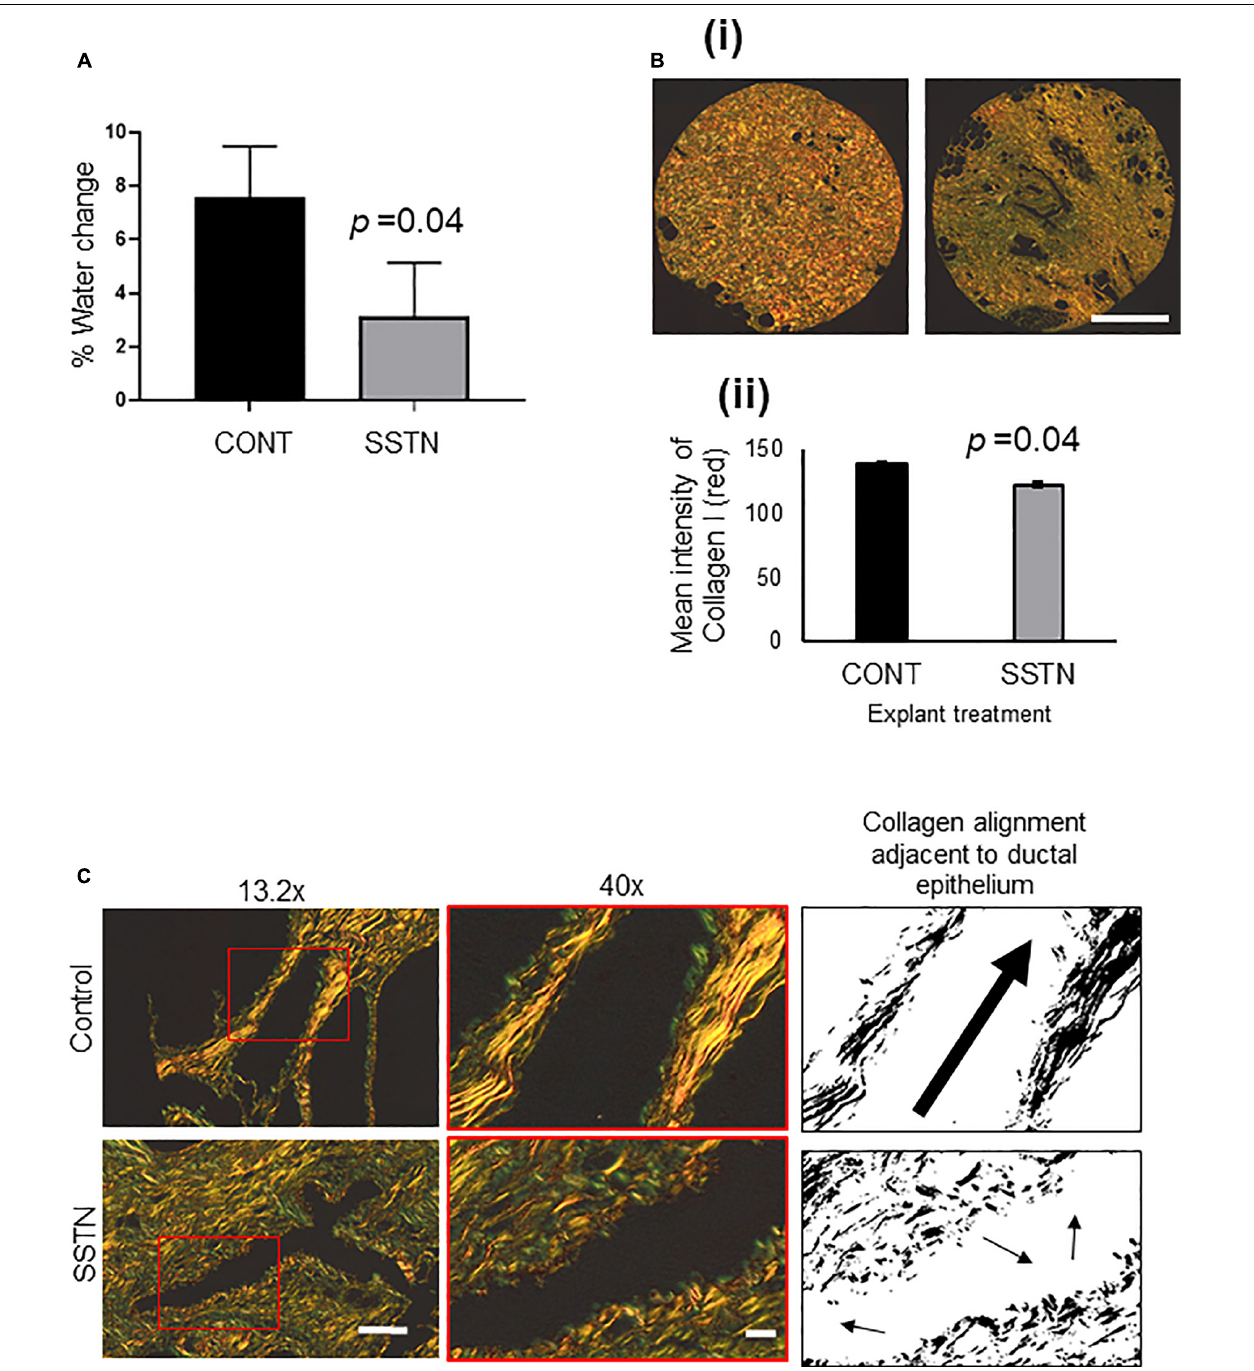
FIGURE 5 | (A) MD change (d14–d0) in SSTN treated mammary tissue explants as measured by the change in % water diffusion values as determined by single-sided NMR. (B) (i) Picrosirius red staining of PDE tissue microarray and imaging with polarized light to visualize dense collagen fibers; (ii) quantification of dense collagen represented as the mean intensity of red fibers visualized by polarized light (data from n = 3 patients, 3 explants quantified per patient). Results are the mean and error bars represent standard error. P -value was determined using Student’s paired T -test. Images captured at 4x magnification, scale bar = 200 mm. (C) Picrosirius red images, enlarged region of image on left is within red box, then black and white thresholded image to highlight changes to alignment of collagen adjacent to ductal epithelium after treatment with Synstatin. Images captured at 13.2 × magnification, scale bar = 100 µ M, 40 × magnification, scale bar = 20 µ M.